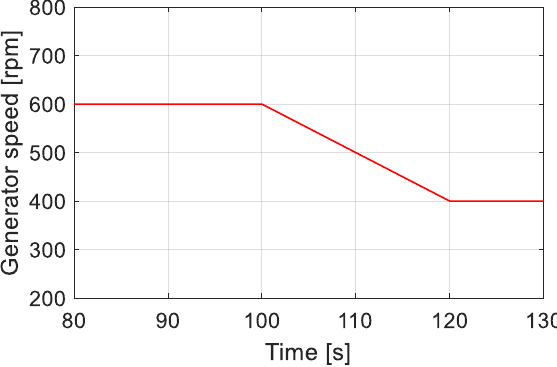
Figure 17. Speed reduction from 600 rpm to 400 rpm.